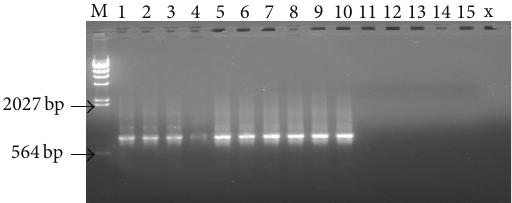
Figure 2: Representative ethidium bromide-stained 1% agarose gel pictures showing amplification products ( ≈ 825 bp) of